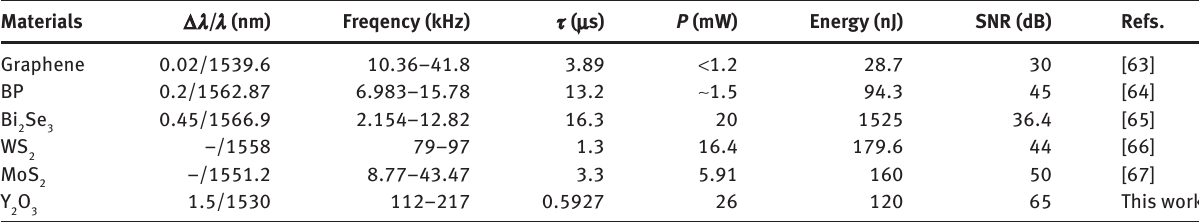
Table 2: Performance comparison of SA-based